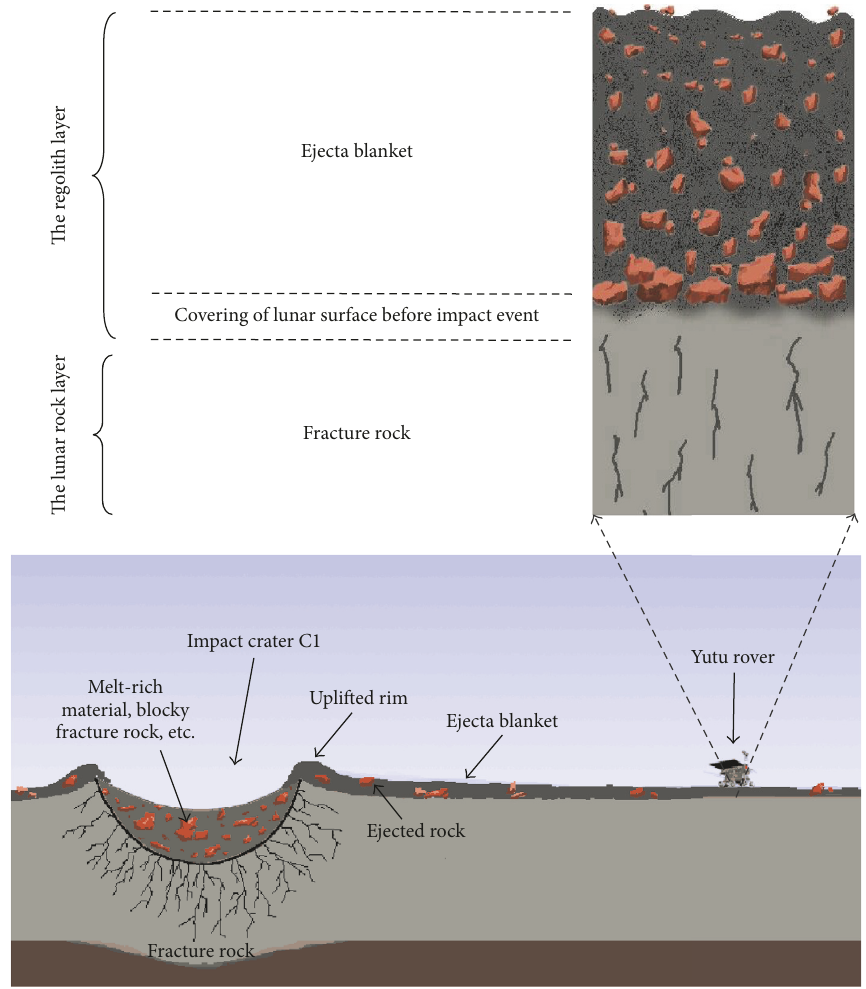
Figure 8: The diagram of the interior structure of the lunar regolith layer at the Chang’E 3 landing